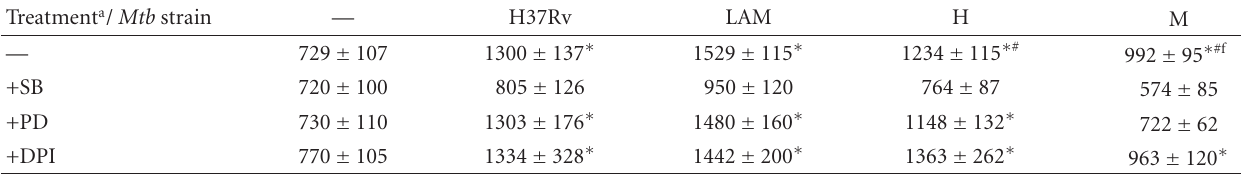
Table 1: CD11b expression on 3h-cultured PMN stimulated with Mtb strains and treated or not with MAPK or ROS inhibitors. Treatment a / Mtb